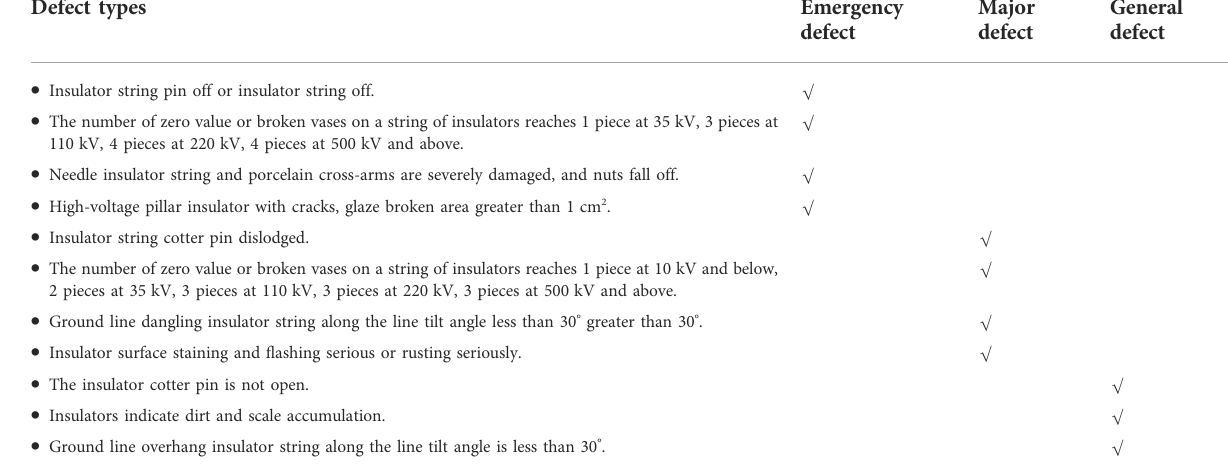
TABLE 1 Insulator defects and severity